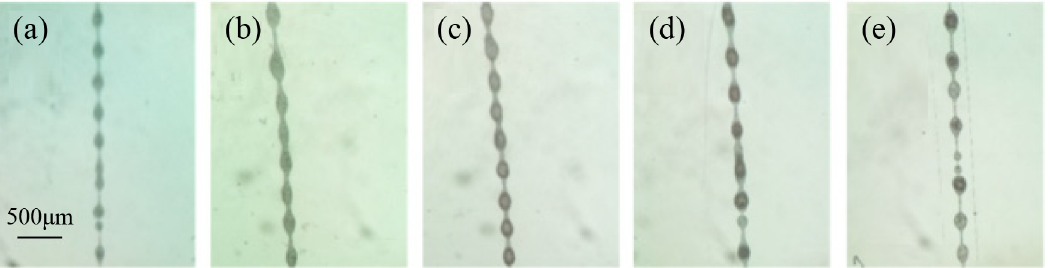
Figure 7. Direct-write micro-droplets on a silicon substrate under different voltage amplitudes: ( a ) 1523; ( b ) 1583; ( c ) 1647; ( d ) 1719; and ( e ) 1792 V. Voltage frequency, solution supply rate, nozzle inner diameter, distance between the nozzle and collector, and platform moving speed are 200 Hz, 60 μL/h, 60 μm, 3 mm, and 50 mm/s, respectively.